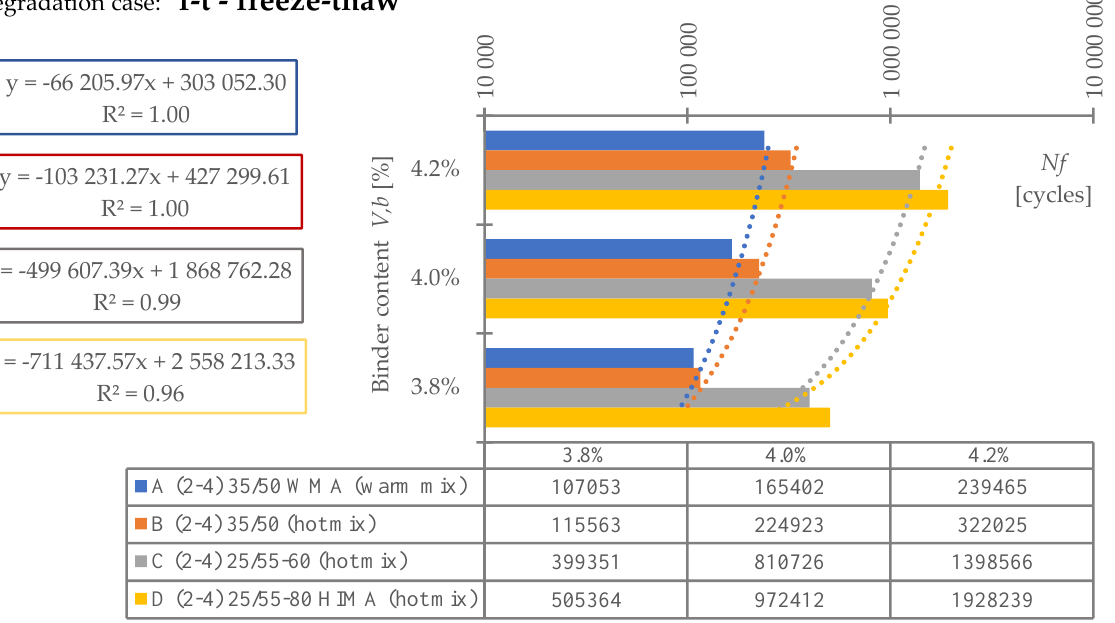
Figure 9. Fatigue test results — water-frost impact.